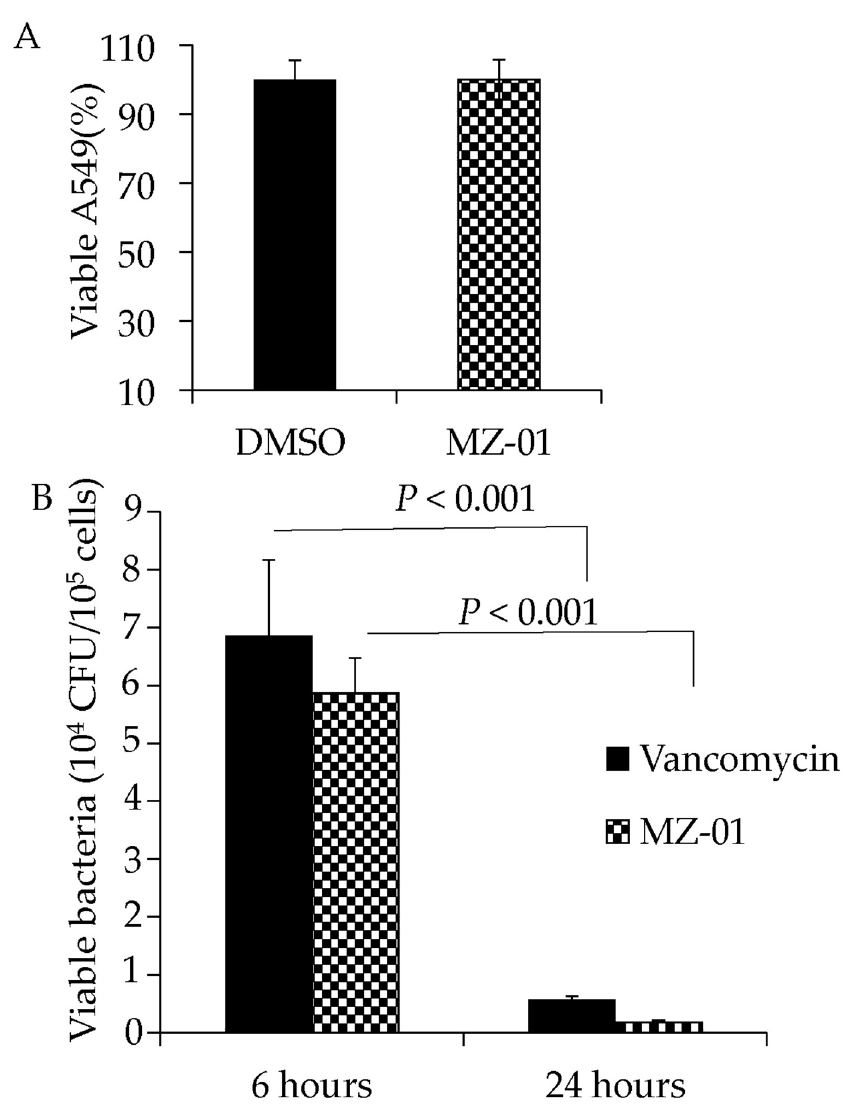
Figure 3. Examination of cytotoxicity and antibacterial activity in human lung epithelial A549 cells. ( A ) Effect of MZ-01 on the viability of A549 cells. The epithelial cells (A549) were incubated in RPMI 1640 medium with 10% FBS. Monolayers of A549 cells (2 × 10 5 cells well − 1 ) were exposed to MZ-01 in DMSO. Control cells were exposed to DMSO vehicle control. Cell viability was measured after 24 h treatment and is expressed as an average of at least three experiments ± standard deviation. ( B ) Recovery of viable MRSA from A549 cells at different time points after treatment with MZ-01 or control vancomycin. Monolayers of A549 cells (2 × 10 5 cells well − 1 ) were infected by approximately 3 × 10 6 cfu of WCUH29. The extracellular bacteria were removed 1 h after infection. Cell viability was measured at different time points after treatment and is expressed as an average of at least three experiments ± standard